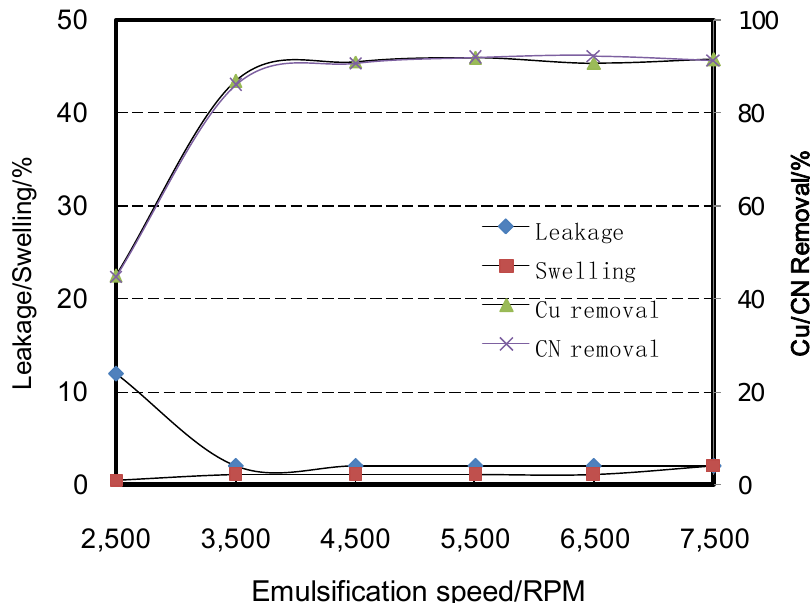
Figure 3. Effect of emulsification speed on ELM stability and copper and cyanide removal. (For ELMs formation, membrane phase: 6% v / v LIX 7950, 2% v / v 1-dodecanol, 5% v / v Span 80, 1% v / v liquid paraffin, balanced with kerosene; Internal phase: 0.05